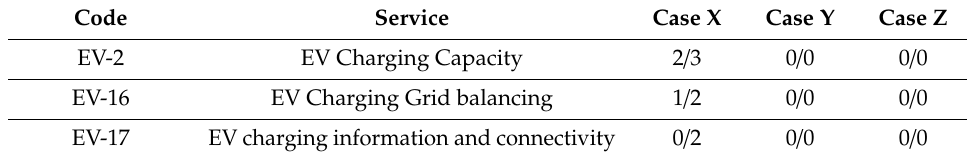
Table 11. The functionality levels in the main domain of electric vehicle charging (EV).